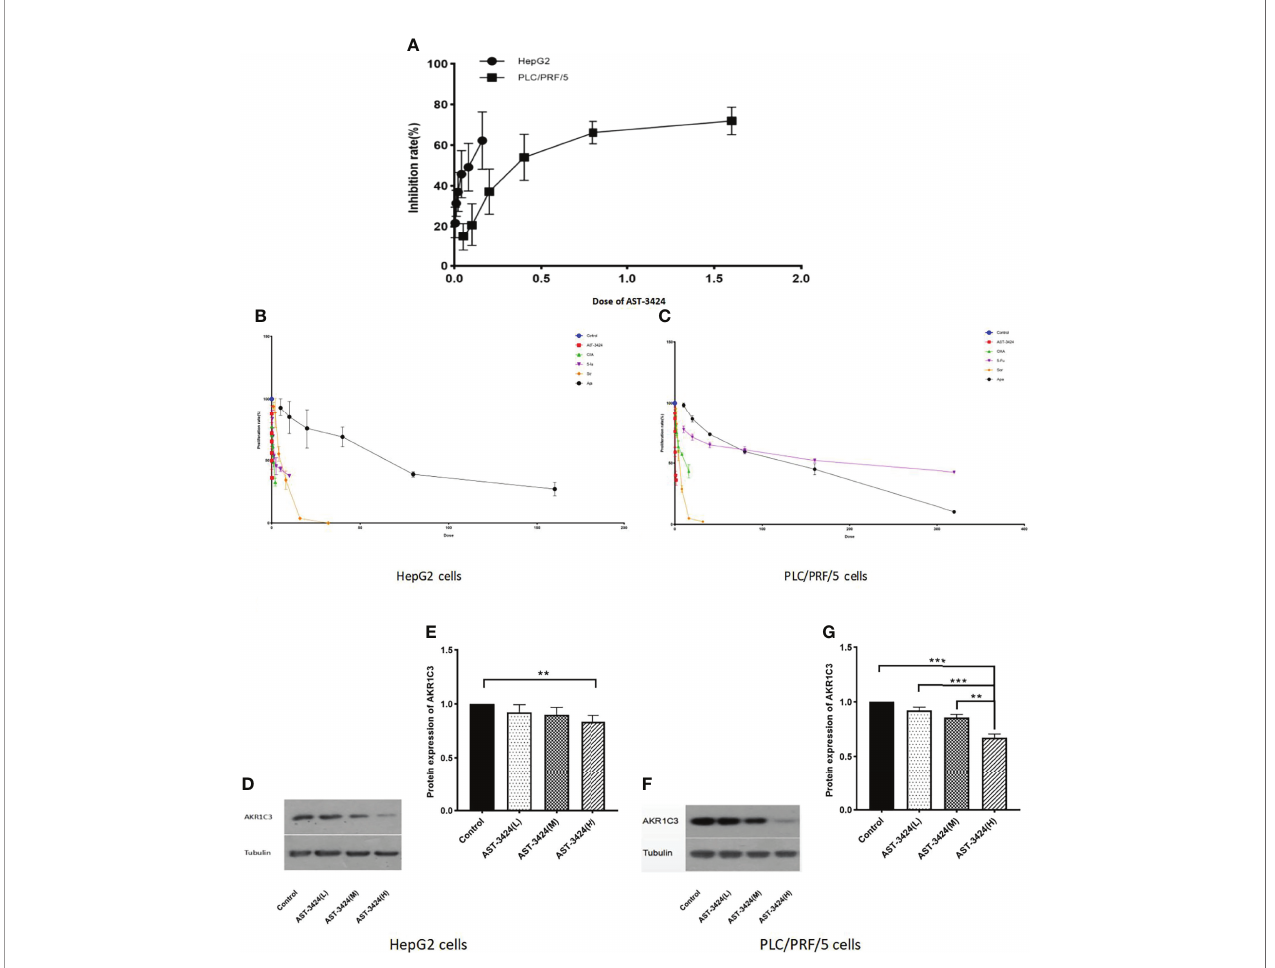
FIGURE 1 | Inhibition of AST-3424 in HepG2 and PLC/PRF/5 cells. (A) Inhibition at different concentrations of AST-3424 (0.005 – 0.16 m M) in HepG2 and AST-3424 (0.05 – 1.6 m M) in PLC/PRF/5 cells. (B) The effect of different concentrations of AST-3424 (0.005 – 0.16 m M), oxaliplatin (OXA) (0.0625 – 2 m g/ml), 5- fl uorouracil (5-Fu) (0.3125 – 10 m g/ml), sorafenib (Sor) (1 – 32 m g/ml), and apatinib (Apa) (5 – 160 m g/ml) treated for 48 h in HepG2 cells. (C) The effect of different concentrations of AST- 3424 (0.05 – 1.6 m M), OXA (0.5 – 16 m g/ml), 5-Fu (10 – 320 m g/ml), Sor (1 – 32 m g/ml), and Apa (10 – 320 m g/ml) treated for 48 h in PLC/PRF/5 cells. (D – G) AKR1C3 protein expression levels in HepG2 and PLC/PRF/5 cells following treatment with different concentrations of AST-3424. All data are displayed as the mean ± SEM of biological triplicates; * p < 0.05, ** p < 0.01, *** p <